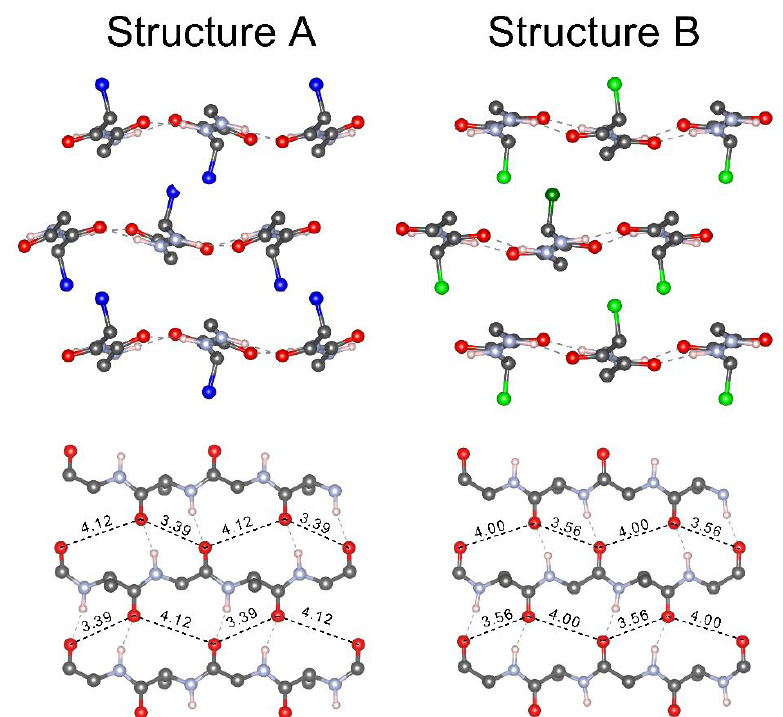
Figure 3. Molecular models of structures A (left column) and B (right column). Top row, different methyl orientation of structures A and B with their respective methyl groups labeled blue and green. Bottom row, distances between the closest oxygens in adjacent chains. Distances are measured in Å ngström (Å ) [70].